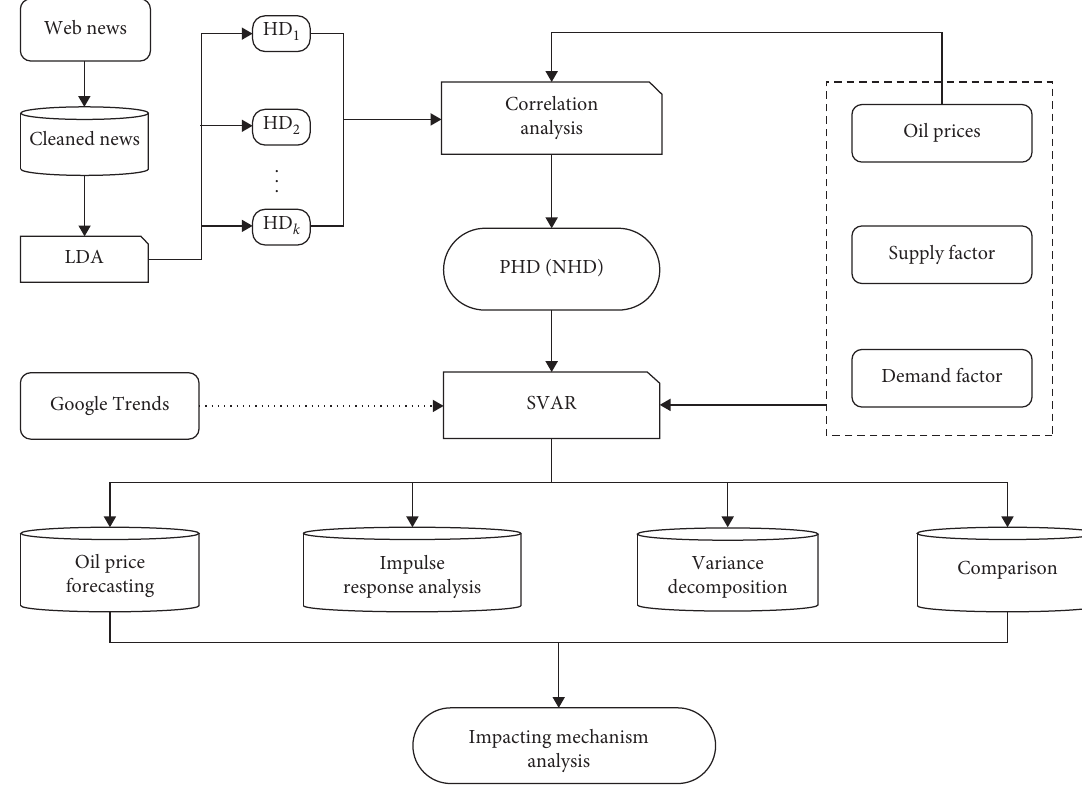
Figure 1: Framework of a HD-based oil price forecasting